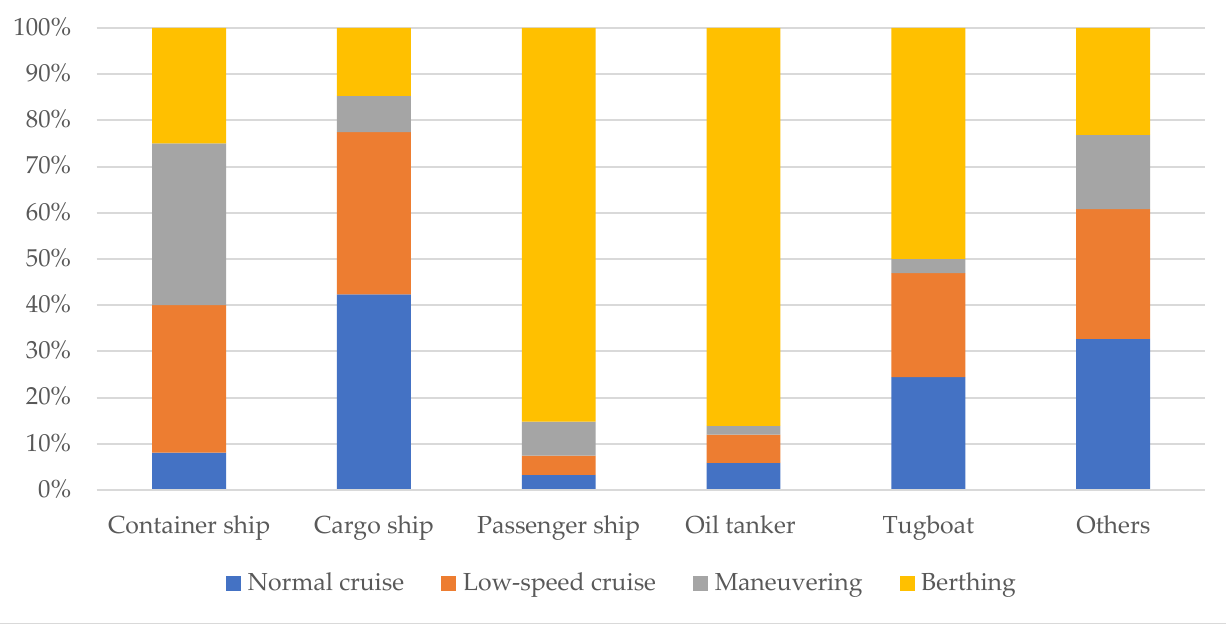
Figure 15. Comparison of SO₂ emissions in different sailing states.